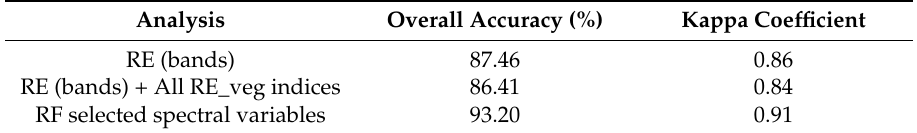
Table 2. Overall accuracies and kappa coefficient of agreement for the Land Use Land Cover classification.